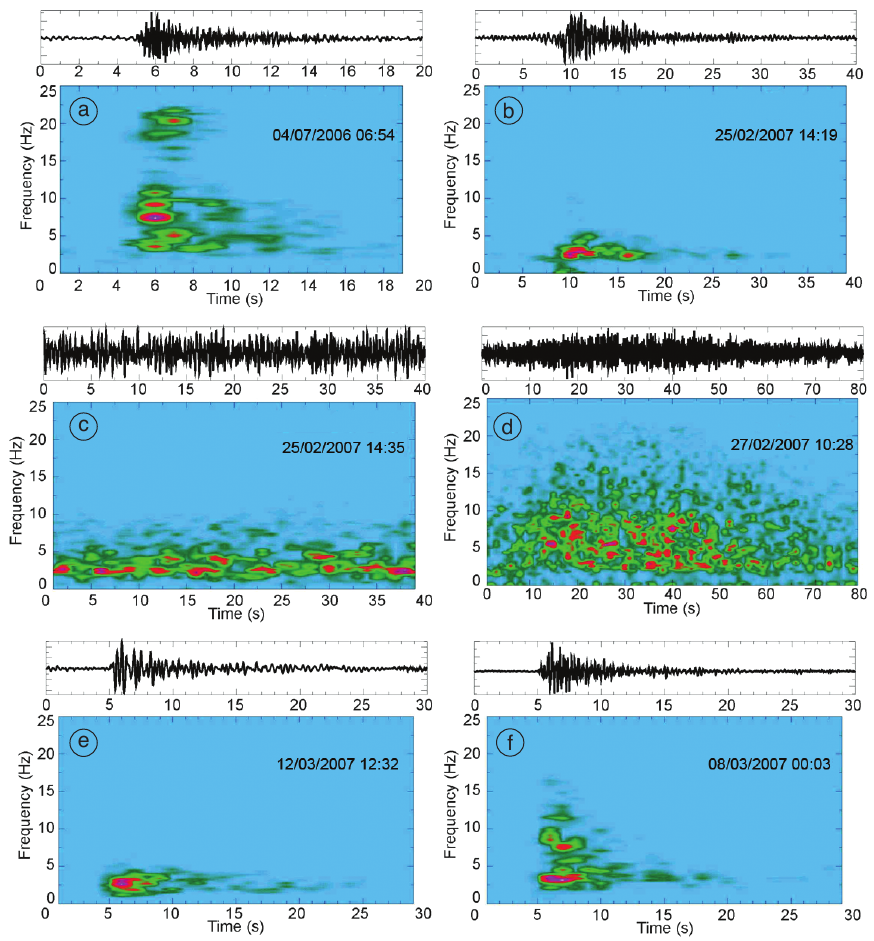
Fig. 2a-f. Seismograms and relative spectrograms of a VT earthquake (a), an explosion-quake (b) a volcanic tremor window (c), a landslide (d) a Long Period event during the effusive phase (e) and an hybrid event (f). Am- plitudes are normalized for both seismograms and spectrograms. Note the similarity among (b) and (e). They are actually related to the same source mechanism (gas slug bursting) that during the effusive phase does not pro- duce summit Strombolian